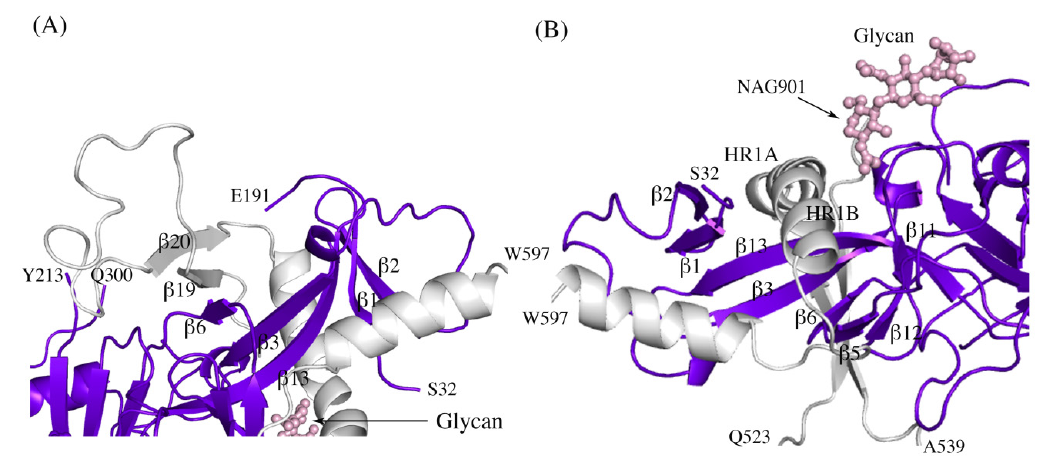
Figure 2. Secondary structure interactions between SUDV-Bon GP (colored blue and 1 (colored light grey). (A) Close up of the continuous seven-stranded purple) and GP 2 twisted  sheet formed by five  strands of the GP base (  2,  1,  13,  3, and  6 in blue) 1 internal fusion loop (  19 and  20 in grey). and two antiparallel  strands of the GP 2 (which contains the grey coils labeled HR1A and HR1B (B) The first heptad repeat of GP 2 and the loop afterwards) is clamped by a horseshoe surface formed by five  strands of base (  , a second small  sheet of the GP base (  and  and a GP 1 1 glycan (pink ball-and-stick). To orient the reader, key residues are